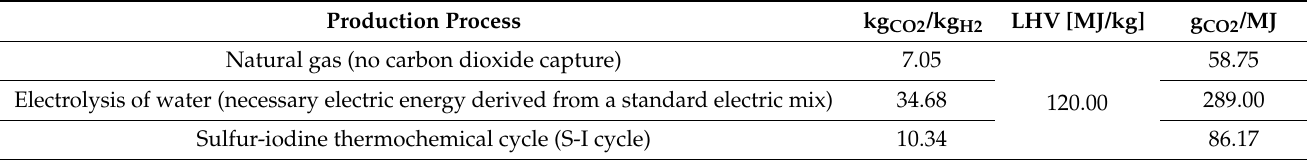
Table 3. GHG emissions for the hydrogen production process (Data source [12]).